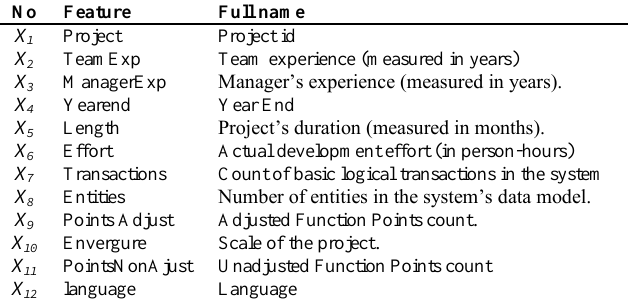
Table 3. Original Desharnais dataset features.